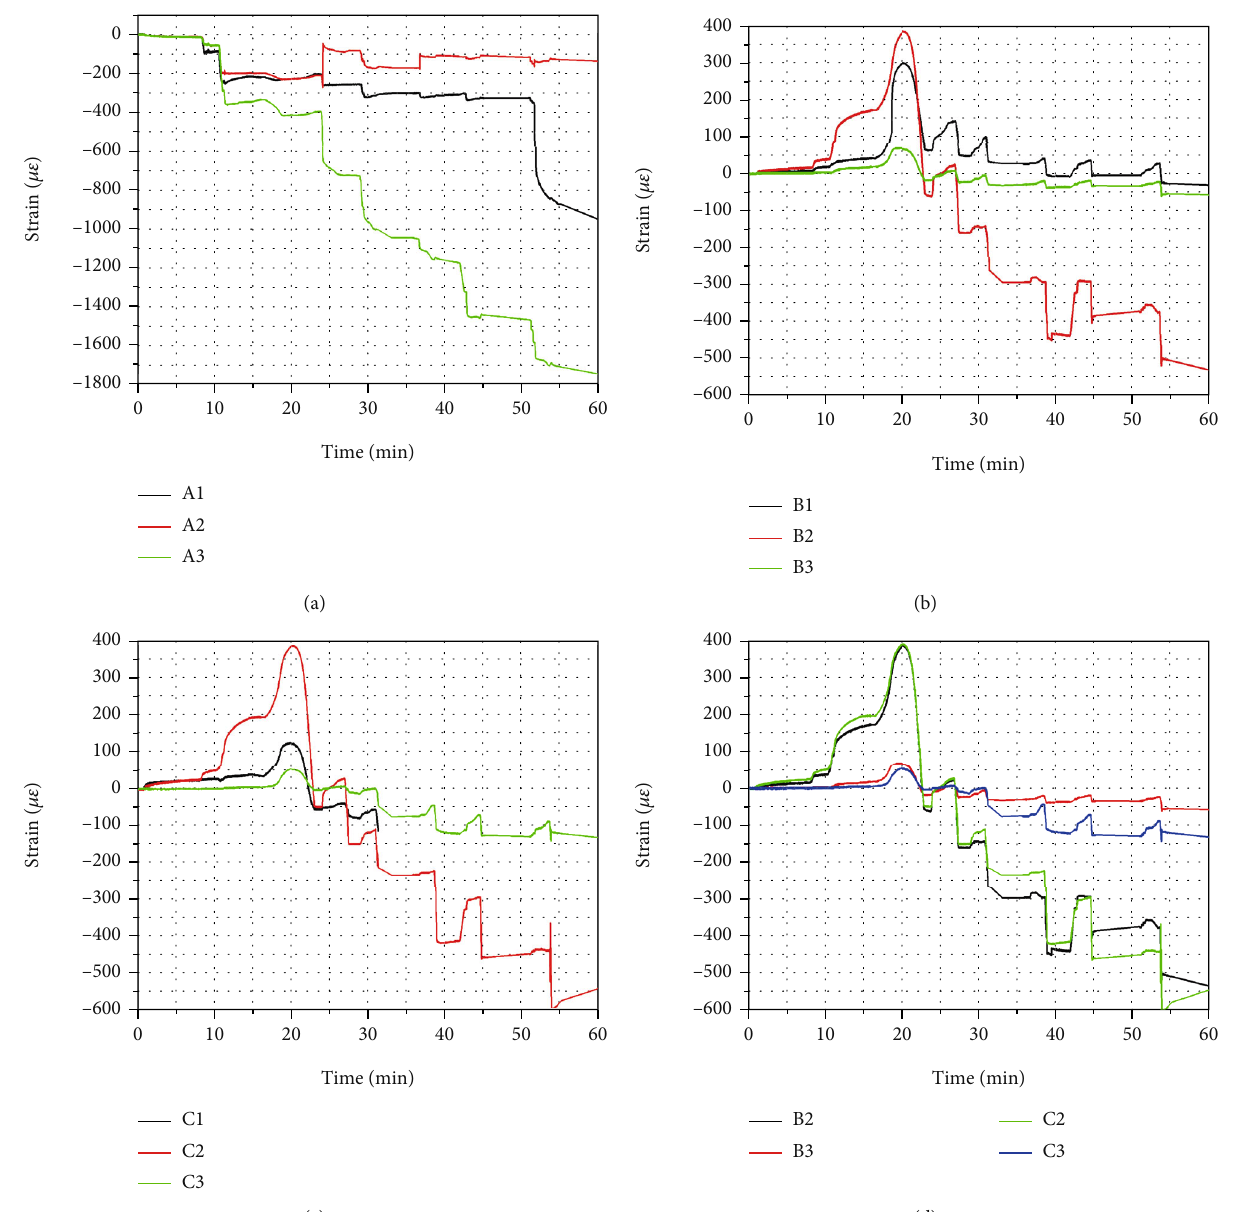
Figure 11: Strains measured by sensors during the loading of con fi ning pressure: (a) vertical A; (b) horizontal B; (c) horizontal C; (d) strains of B and